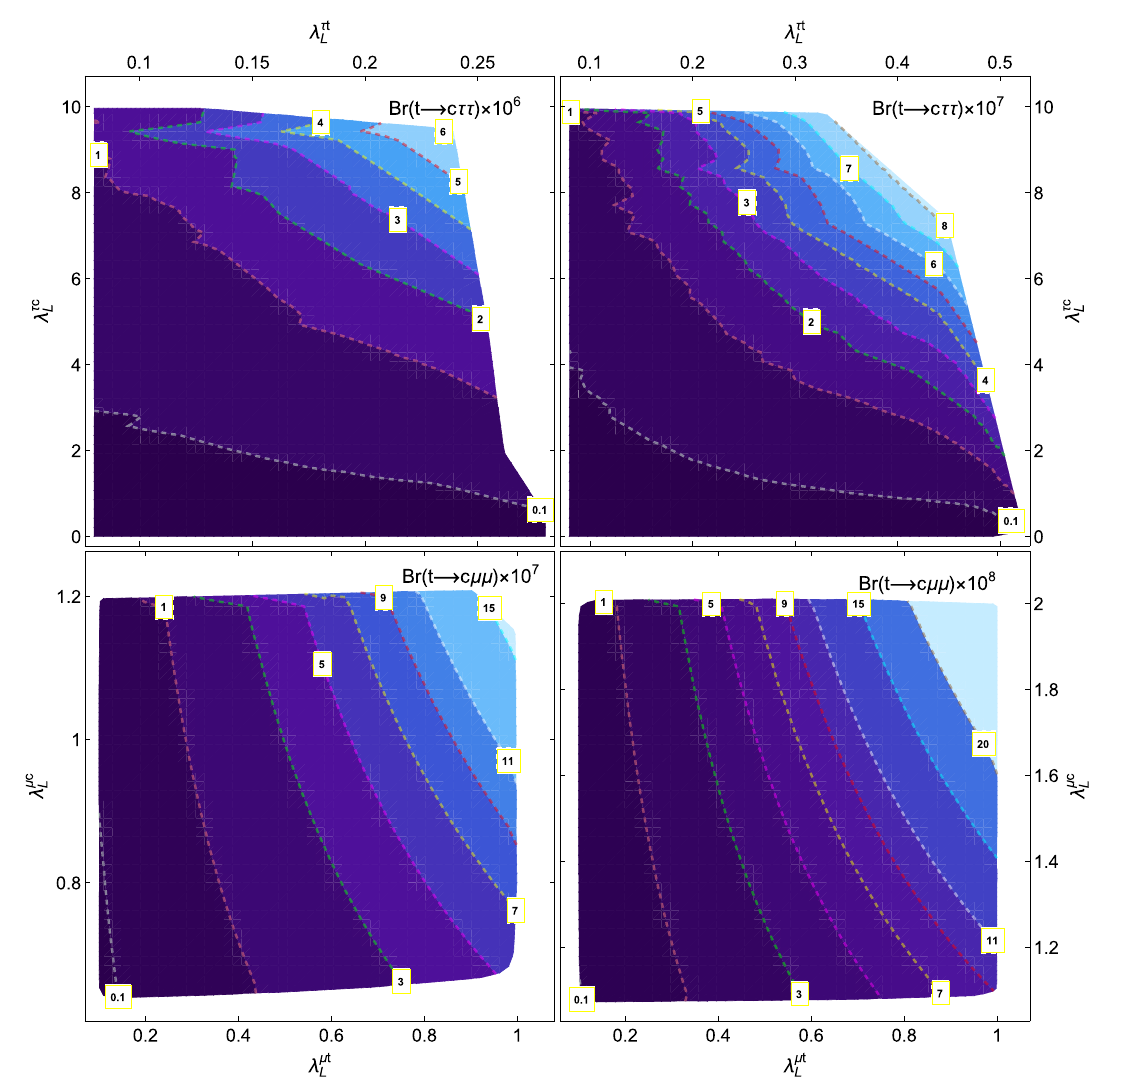
Fig. 10 Contoursofthebranchingratiosofthe t → c ¯ ττ and t → c ¯ μμ = 1000 GeV (left plots) and 2000 GeV (right plots) decays for m Ω 5 / 3 μ c ,λ μ t ,λ τ c ,λ τ t ) values inside the area in the λ (cid:3) t vs λ (cid:3) c plane for (λ L L L L L L